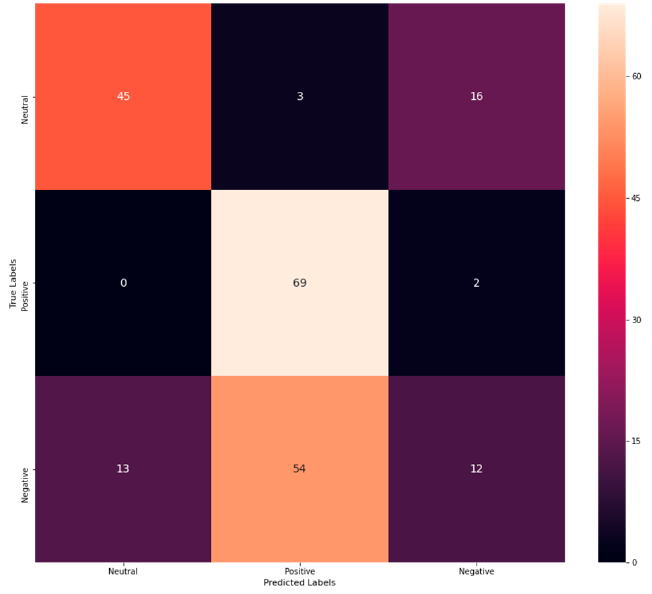
Figure 4. Confusion matrix of DT.